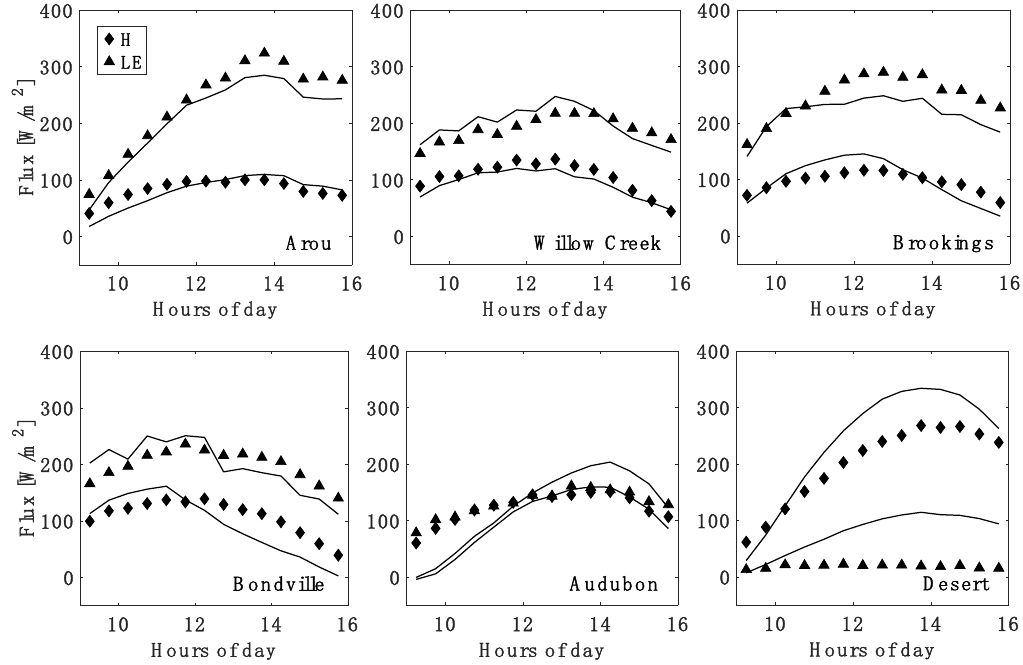
Figure 11. Mean diurnal cycle of estimated (solid lines) and measured (symbols) turbulent heat fluxes from the VDA approach for the six study sites.